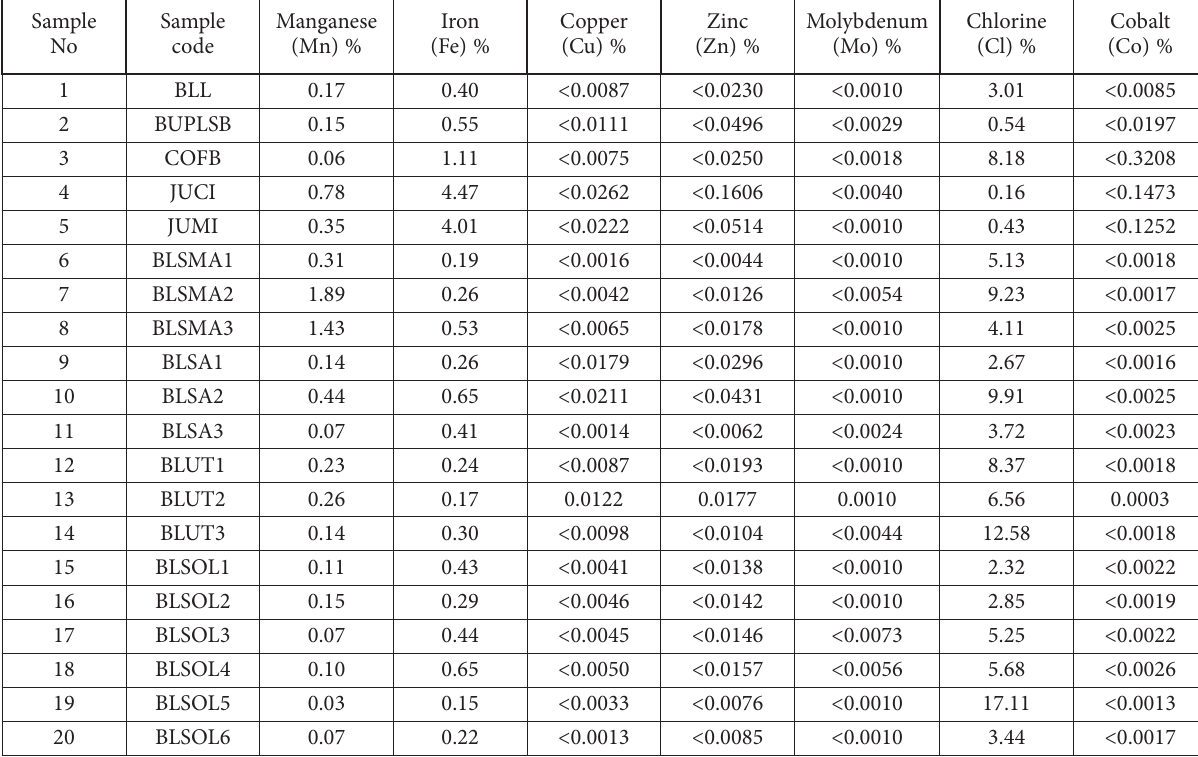
Table 3. Concentrations of micro-nutrients (% by weight) in ash samples of plant